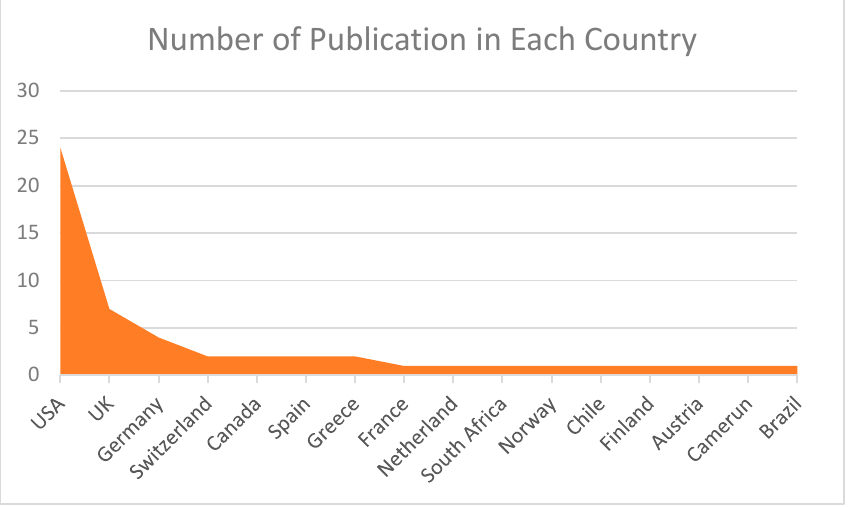
Figure 4. Country of publishing articles based on the collected database.